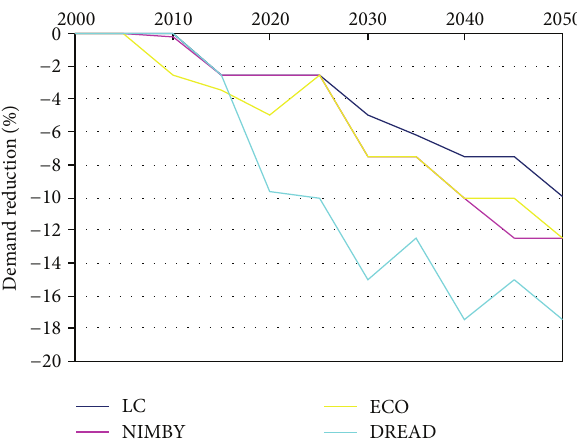
Figure 4: Residential Electricity Demand